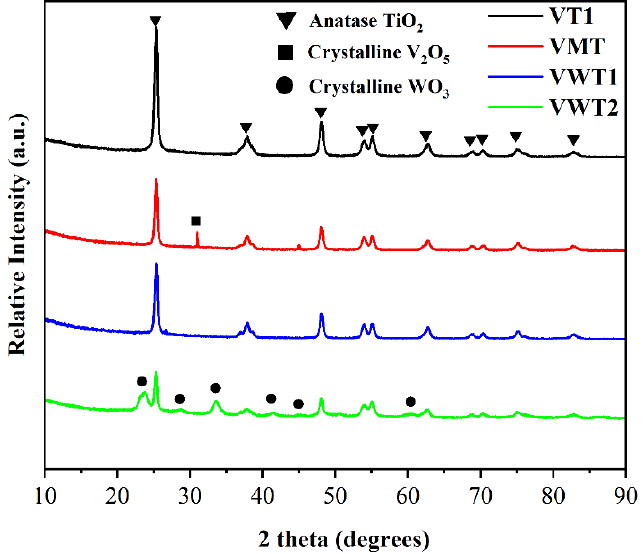
Figure 3. X-ray power diffraction patterns of 4 catalysts, where the symbols ▼ , ■ , and ● denote anatase TiO 2 , crystalline V 2 O 5 , and WO 3 , respectively.